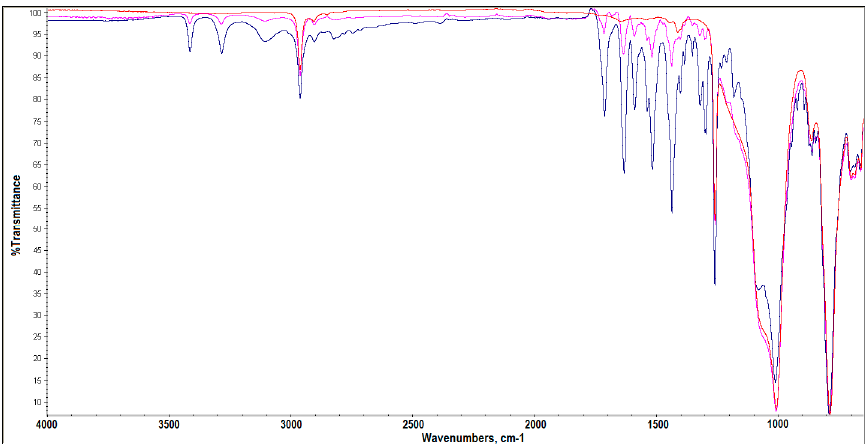
Figure 5. Comparison of the silicone catheter before (red curve) and after (pink and blue curves) immobilization of SPA; the activation with bromine at concentration 0.3% (pink curve) and 1% (blue curve).